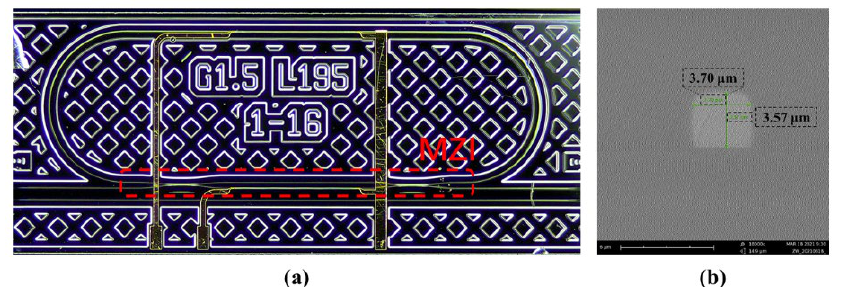
Figure 4. ( a ) Photograph of silica-based tunable MRR; ( b ) scanning electron microscope (SEM) image of core waveguide cross-section.